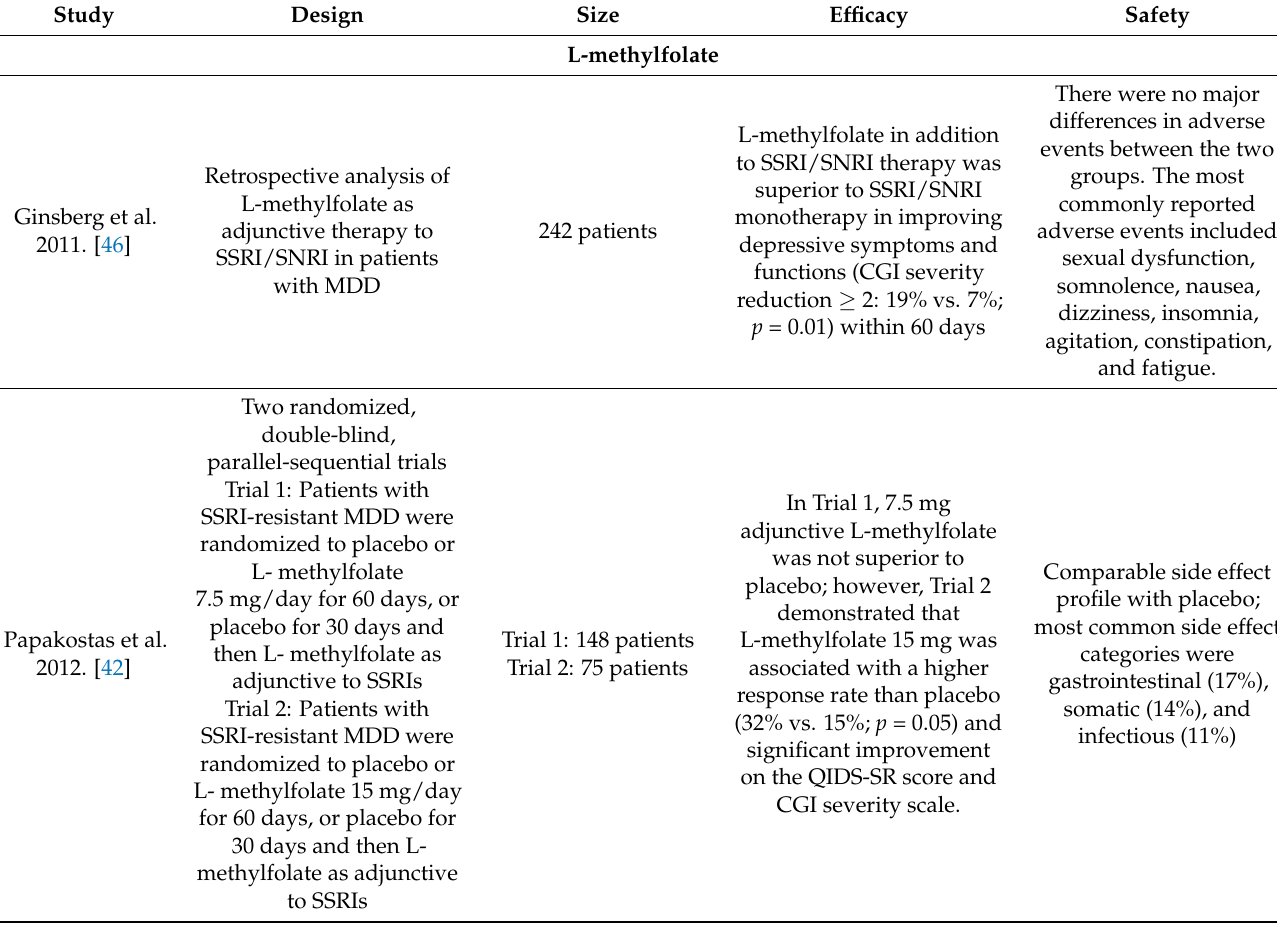
Table 1. Review of the clinical evidence for supplementation in